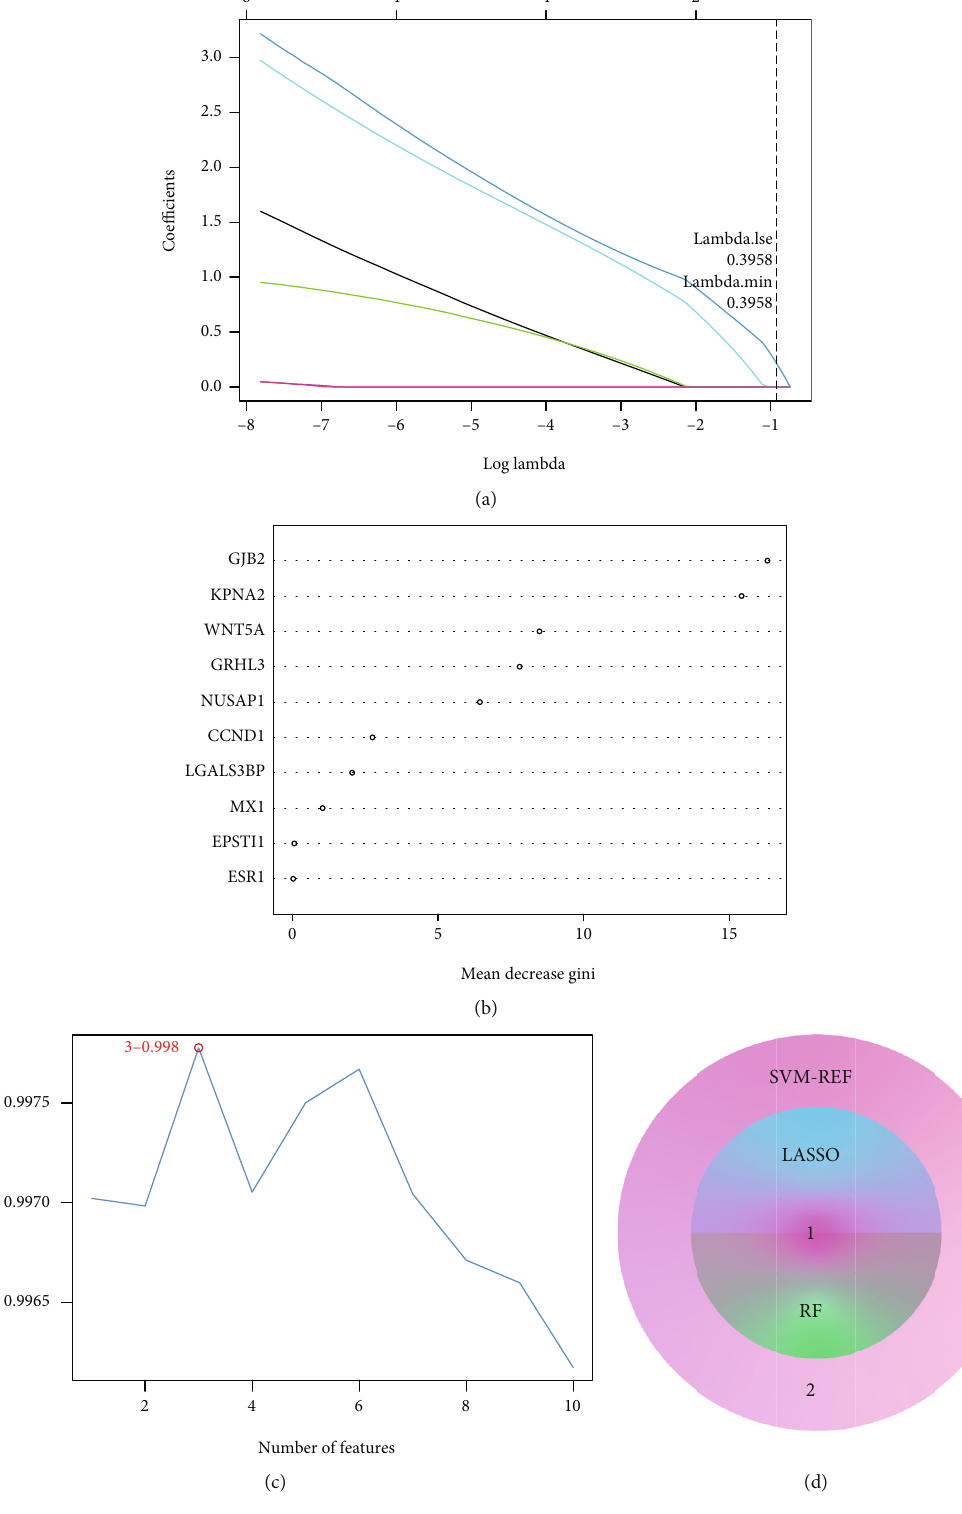
Figure 5: Identi fi cation of the hub gene. (a) Identi fi cation of feature gene by Least absolute shrinkage and selection operator (LASSO) regression analysis. The horizontal axis represents the lambda value and the vertical axis represents the independent variable coe ffi cient. (b) Screen diagnostic markers by Random Forest (RF) model algorithm. The importance of features ranked by mean decrease Gini. (c) Selection genes by the support vector machine recursive feature elimination (SVM-RFE) algorithm. (d) Intersection analysis of feature genes identi fi ed by three